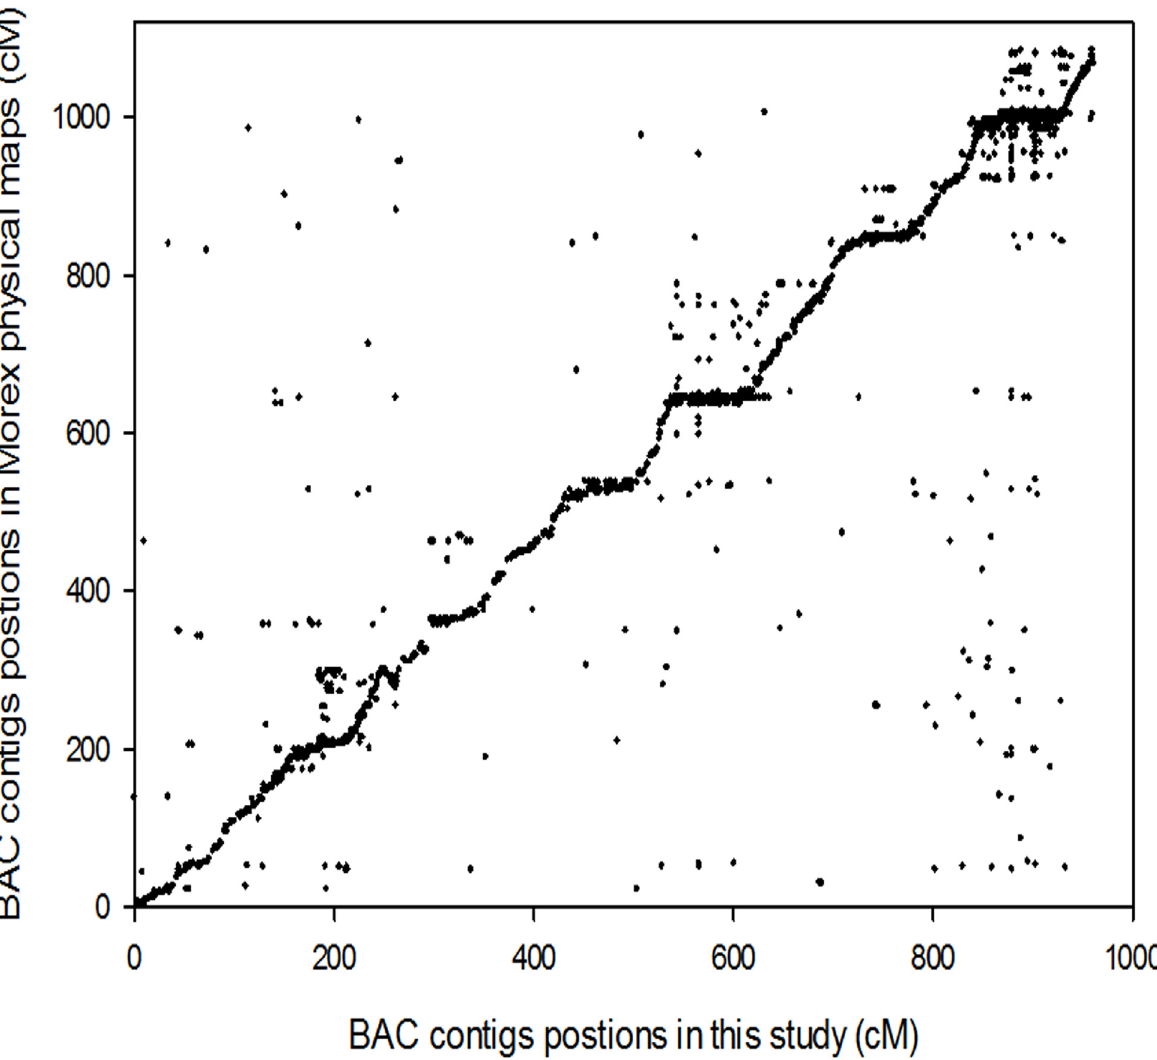
Fig 2. Alignment of BAC contig positions derived from de novo and POPSEQ. A total of 1,355 BAC contigs were dotted in the figure. X-axis indicates the accumulative genetic position in the de novo genetic map; Y-axis indicates the accumulative genetic position in the POPSEQ genetic